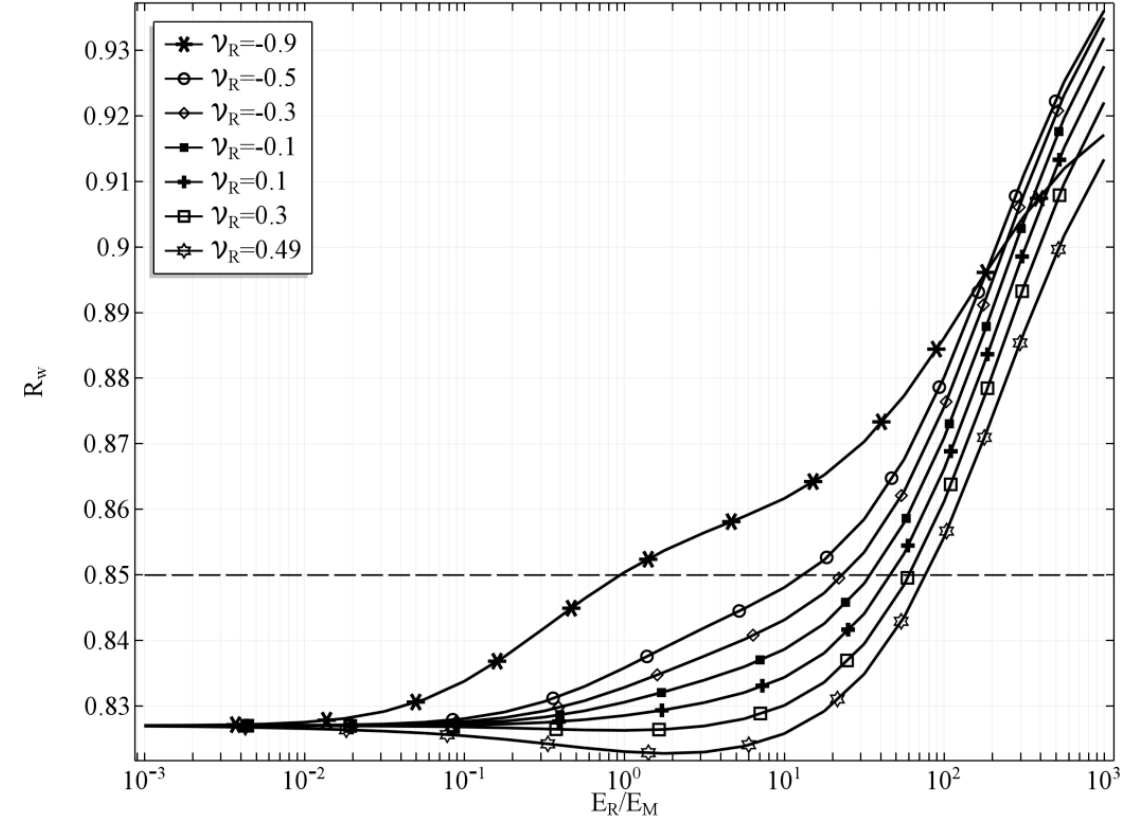
Figure 5. The inner radius of the tube R w with respect to E R /E M ratio for selected values of ν R , t h = 0.2.